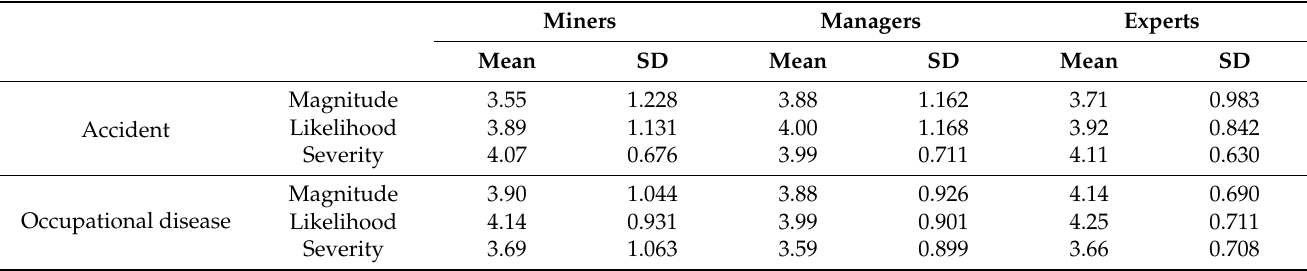
Table 6. Risk perceptions of different groups of